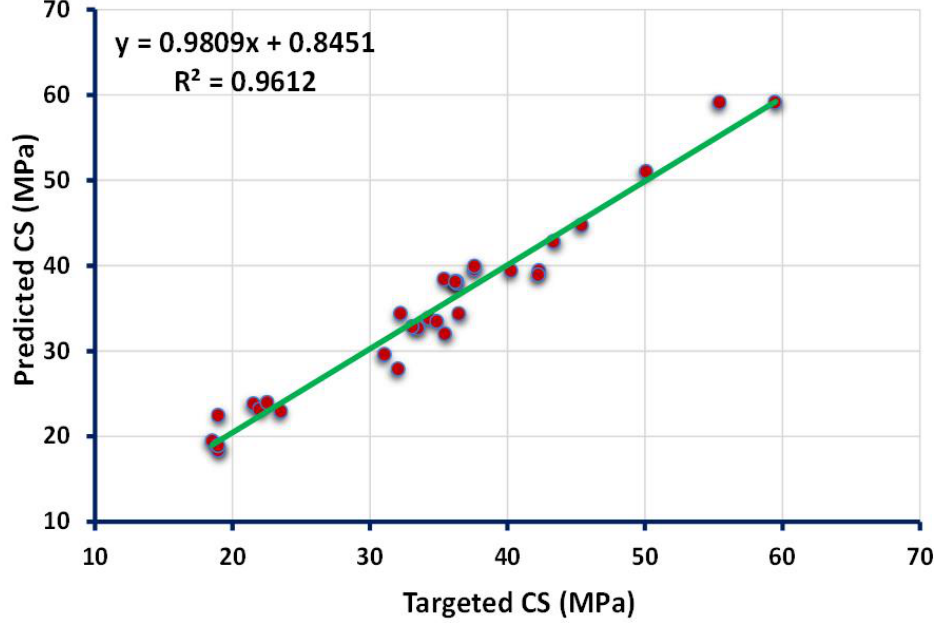
Figure 4. Relationship between the targeted and predicted results obtained from boosting approach.